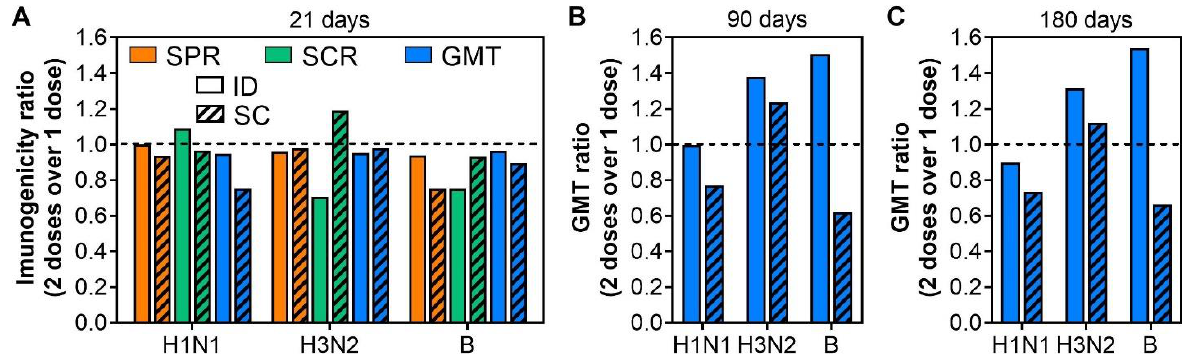
Figure 3. Comparison of immunogenicity induced by one-dose and two-dose regimen of influenza vaccine in the elderly. ( A ) Comparison of immunogenicity induced by one and two doses of ID15 and SC15 at 21 days after the last immunization. The ratios of SPR, SCR, and GMT were calculated by dividing the mean SPR, SCR, and GMT after immunization with two doses by those after one dose. A ratio of <1 (dash line) implies lower immunogenicity of two-dose regimen than one-dose regimen. Similar calculations for GMT ratio were performed at 90 days ( B ) and 180 days ( C ) after the last immunization. Due to limited studies comparing the immunogenicity of one-dose versus two-dose regimen, a statistical test was not performed.